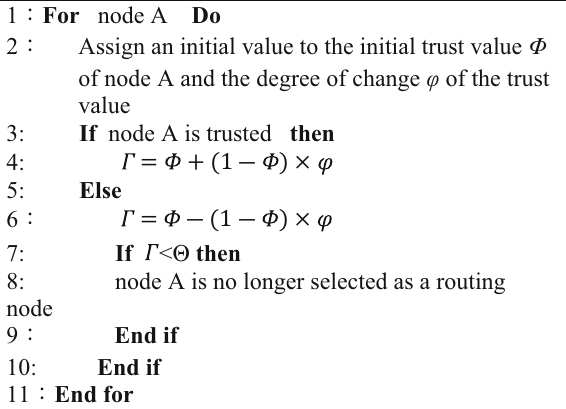
Algorithm 3: Algorithms for Calculating Trust